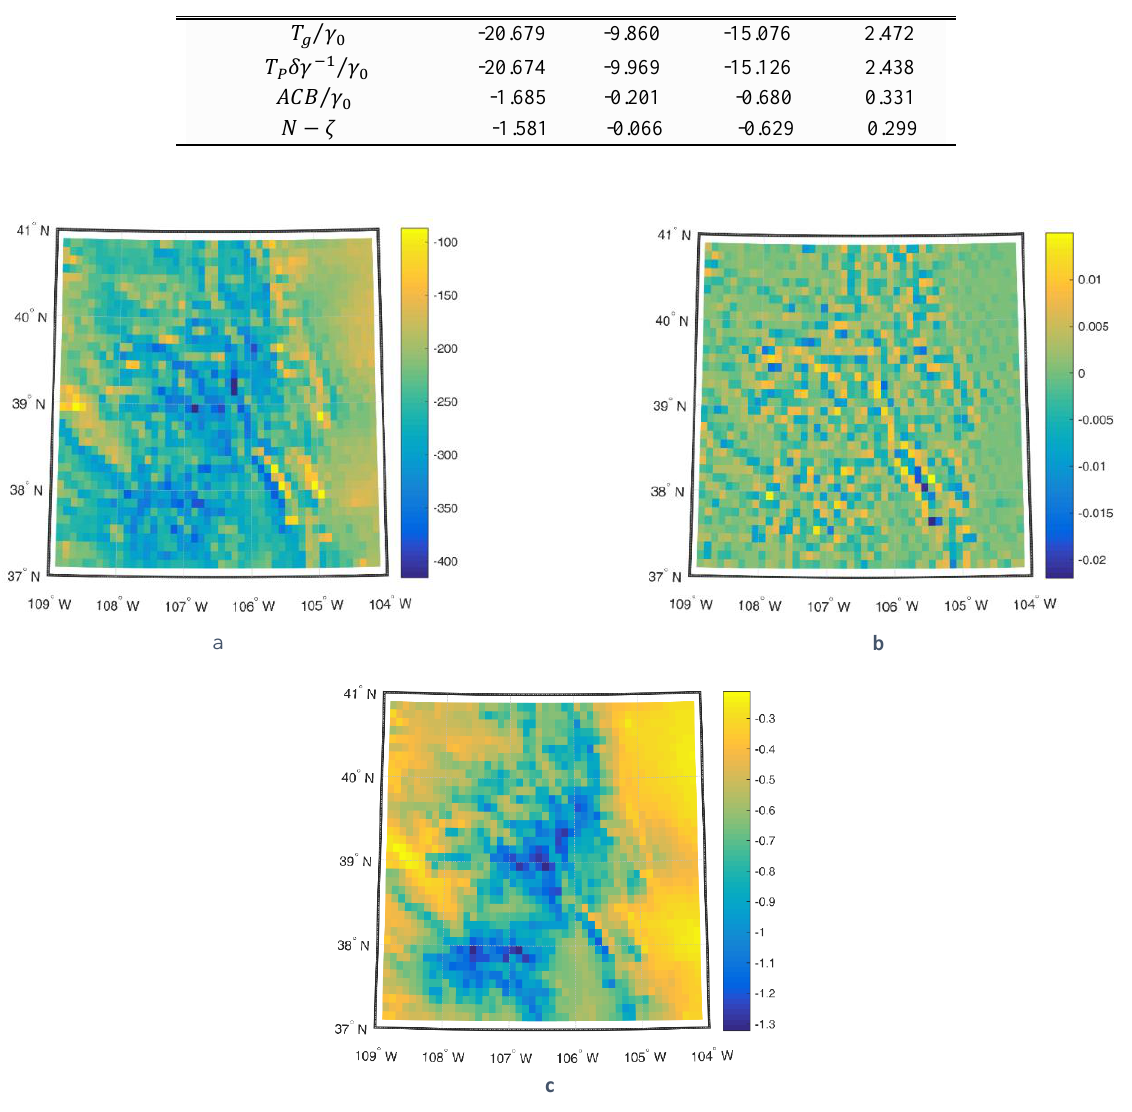
Figure 2. (a) The Bouguer gravity anomaly with 6 arc-min interval, unit: mGal, (b) the vertical gradient of the free air gravity anomaly with 6 arc-min interval, unit: mGal and (c) the GQS obtained from indirect method, unit: m.